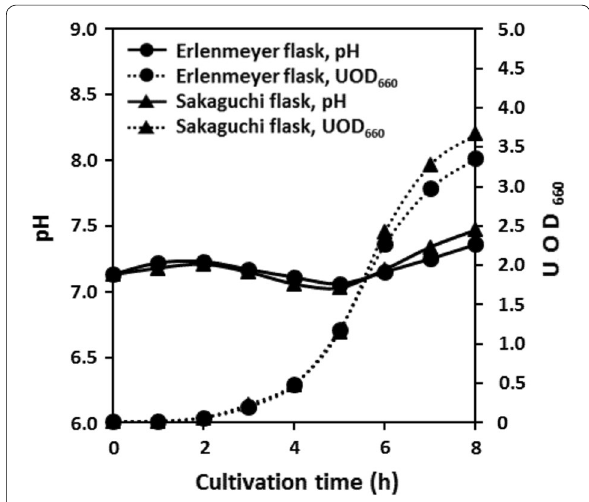
Fig. 2 Changes in culture factors in the conventional shake-flask cultures